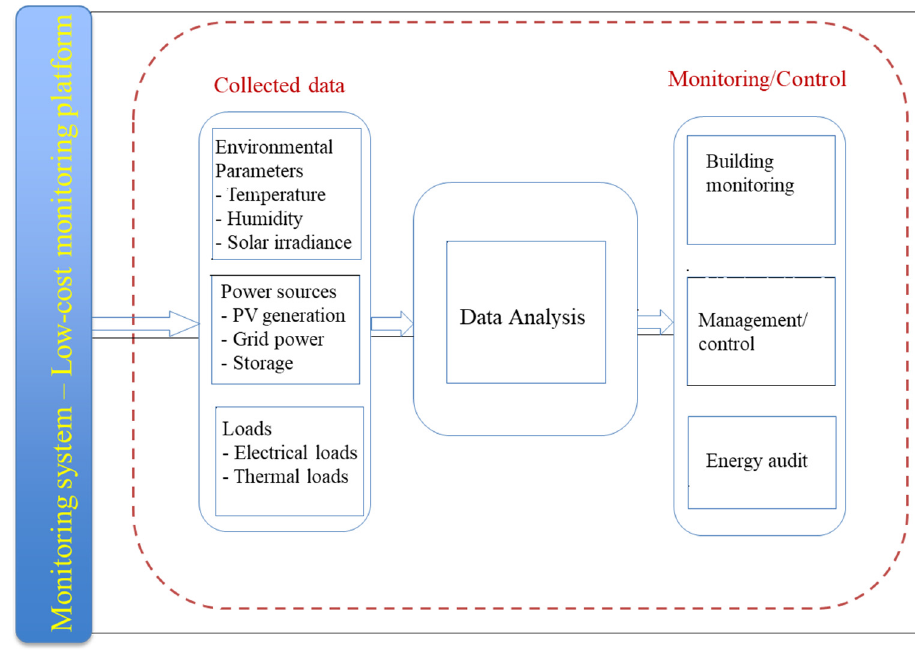
Figure 2. Schematic of energy efficiency management and role of monitoring platform.